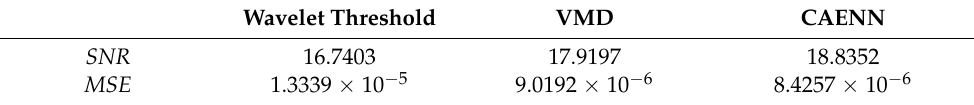
Table 9. The SNR and MSE of signals denoised by three methods shown in Figure 11.